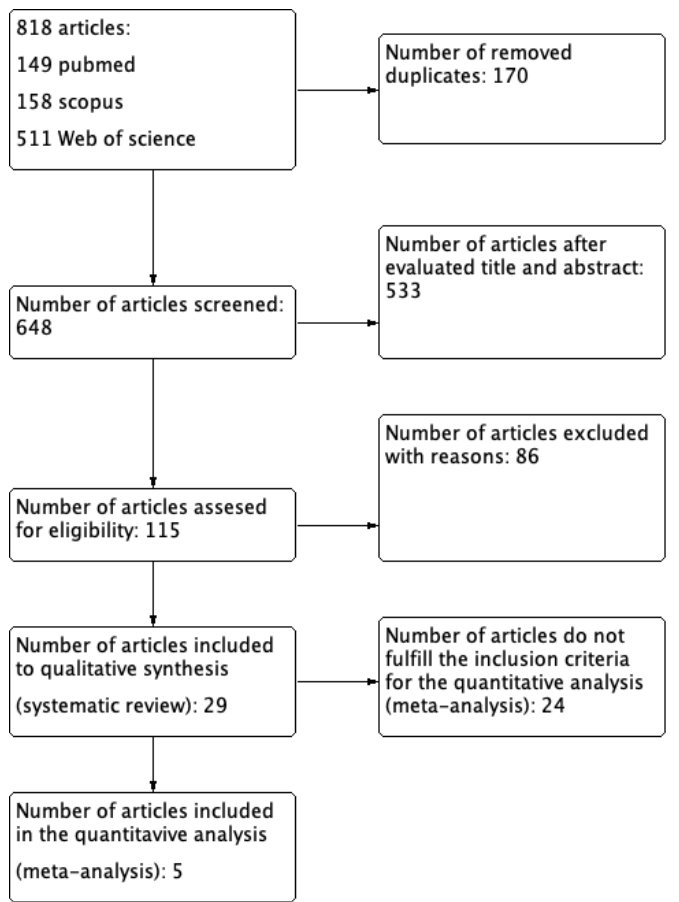
Figure 1. Flow chart of this systematic review.